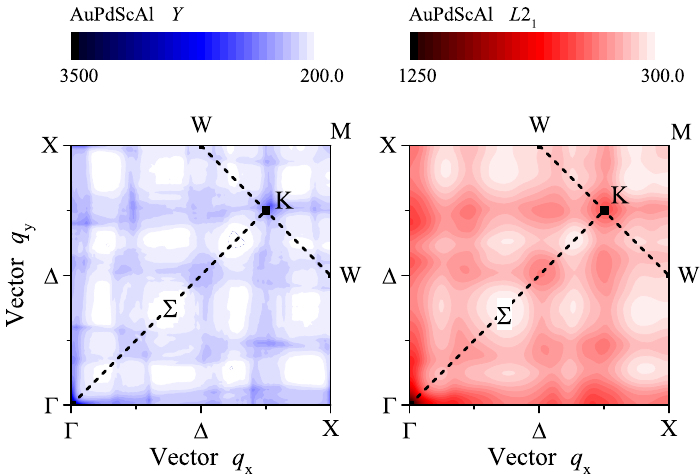
Figure 10. Nesting vectors in ordered and disordered AuPdScAl. The autocorrelation functions ( a 2 ( q ) ) of the Fermi surfaces in the (001) plane of ordered and disordered AuPdScAl are compared for the Y and L 2 1 structures. The high symmetry lines and points in the irreducible wedge of the first Brillouin zone are indicated. The scale of the coloured bars is in atomic